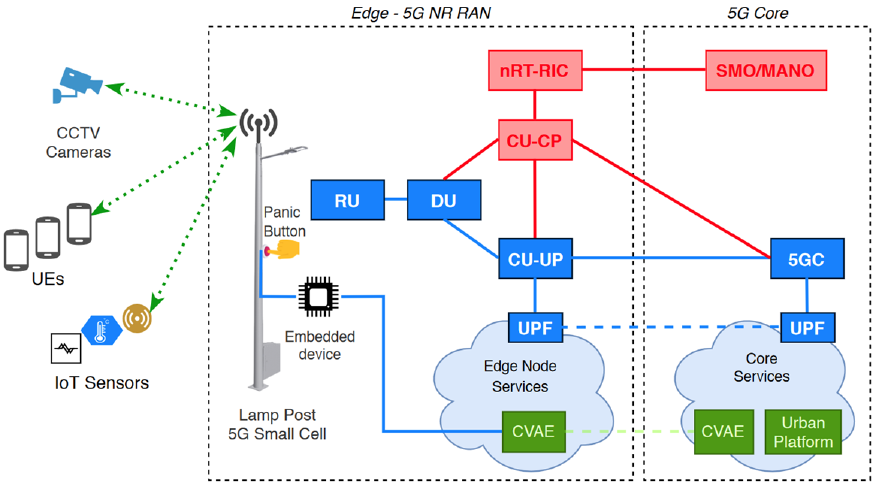
Figure 10. Deployment scenario.